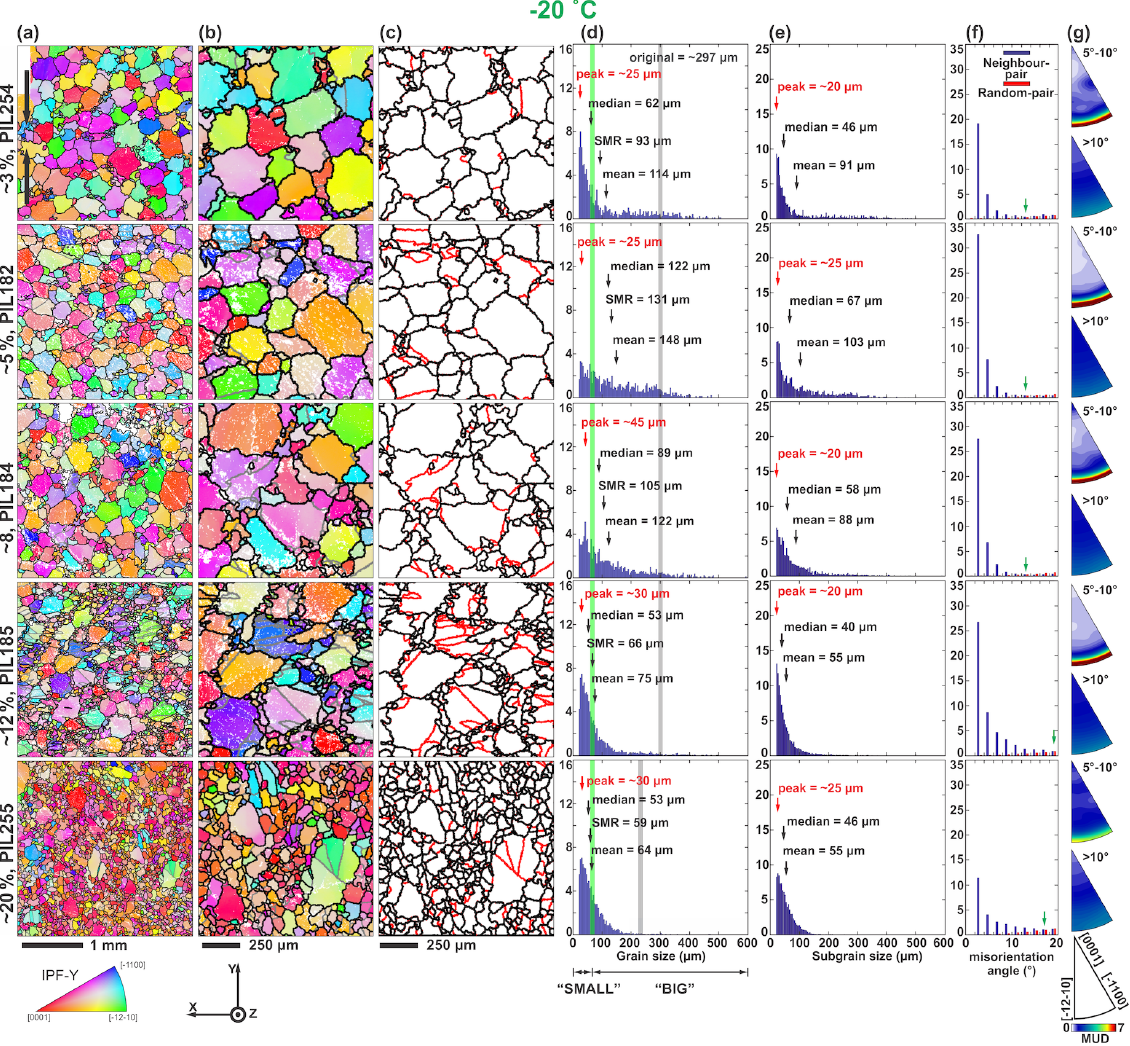
Figure 5. Microstructural analyses of deformed ice samples at − 20 ◦ C. Axial true strain increases from ∼ 3% on top to ∼ 20% on the bottom. The descriptions of columns (a) to (g) are the same as in Fig.